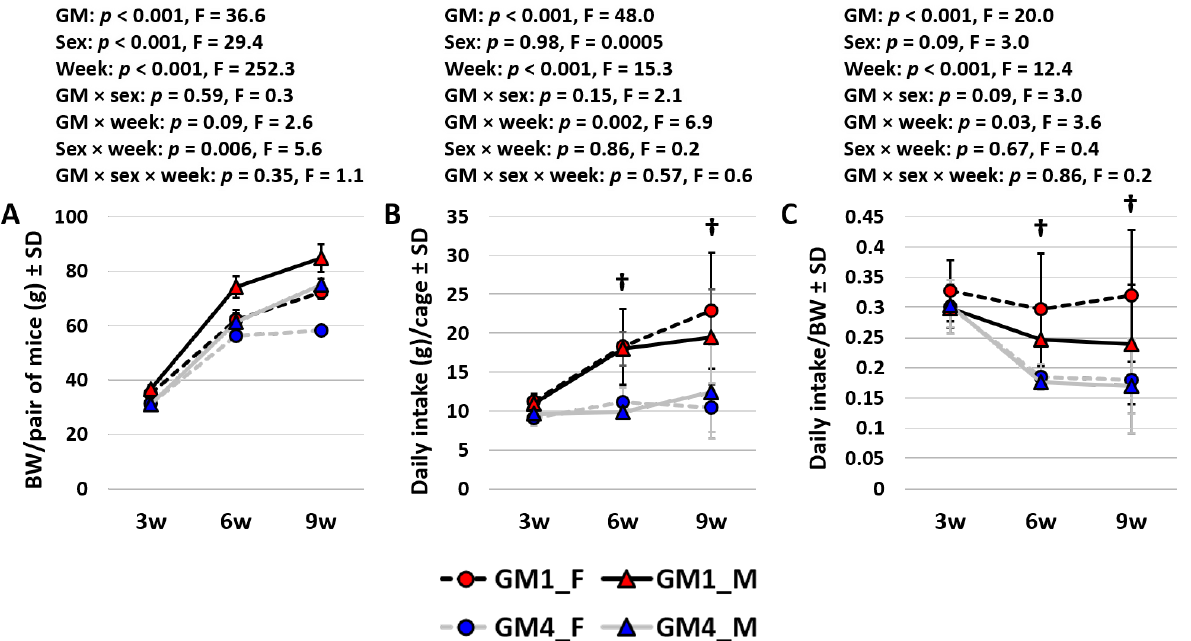
Figure 3. Line plots showing the mean (±SD) body weight (BW) ( A ), total daily intake ( B ), and BW- adjusted daily intake ( C ) in cages housing pairs of female (F) or male (M) mice colonized with GM1 or GM4 at three (3 w), six (6 w), and nine weeks (9 w) of age ( n = 5 – 6 cages/sex/GM). Statistical